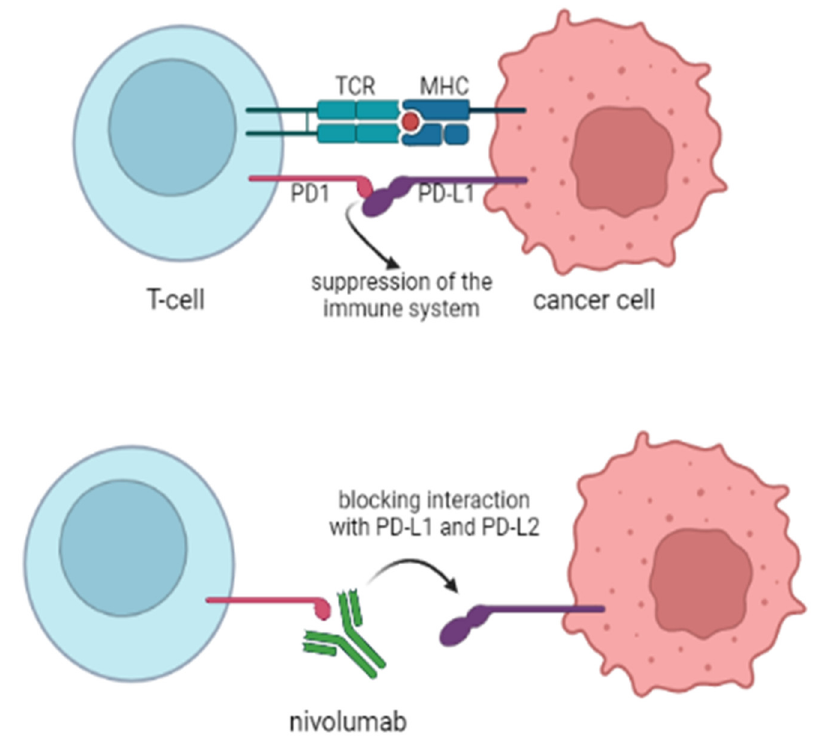
Figure 4. Construction of the CAR-T cell.